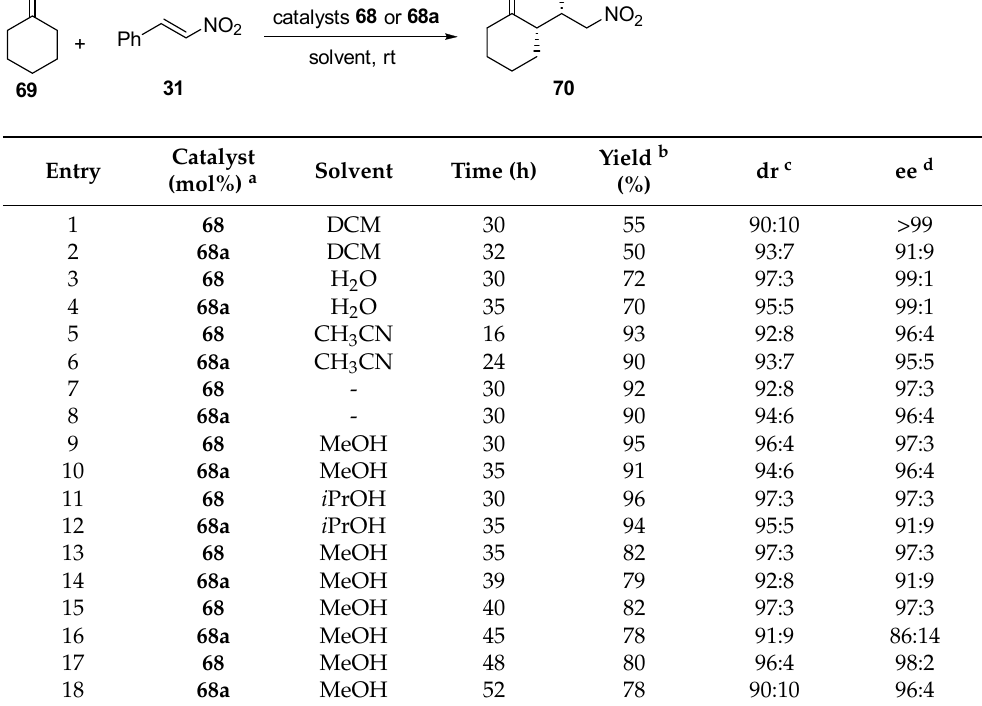
Figure 8. ROE-restrained molecular dynamics studies for catalyst 68 ( a ) and 68a ( b ). Adapted with permission from [51] .